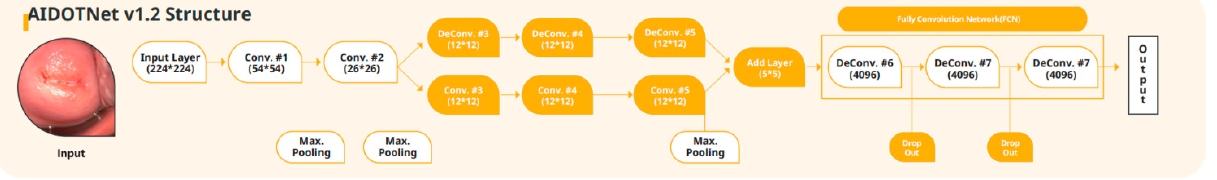
Figure 4. An algorithm of the deep learning process of Cerviray AI ® . Briefly, it included the input of an image, multiple convolution and deconvolution networks of image processing while pooling and dropping out of data, and output of the result.